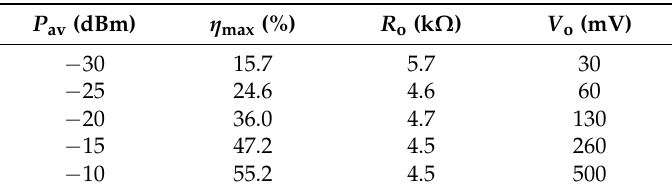
Table 3. Experimental results of η max , R o , and V o .